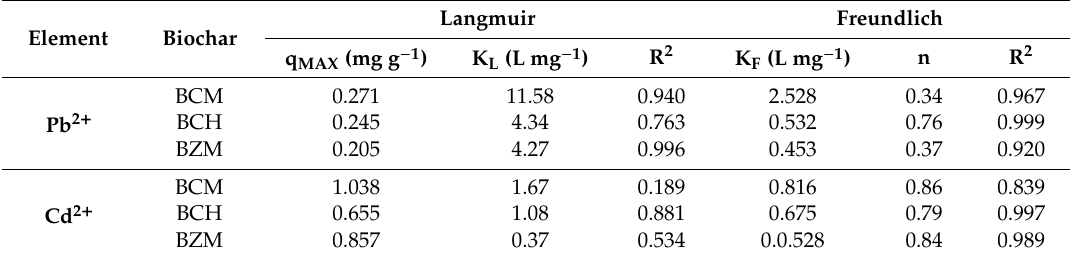
Table 5. Fit to mathematical models of isotherms.